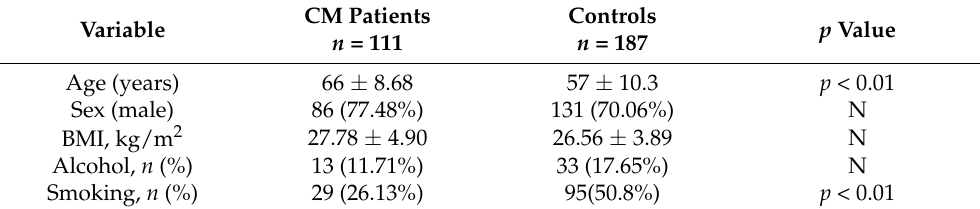
Figure 5. Study design. Patients with cardiomyopathy ( A ) and the healthy volunteers ( B ) recruited for the current study. Table 1. Demographics and clinical characteristics of control and patient